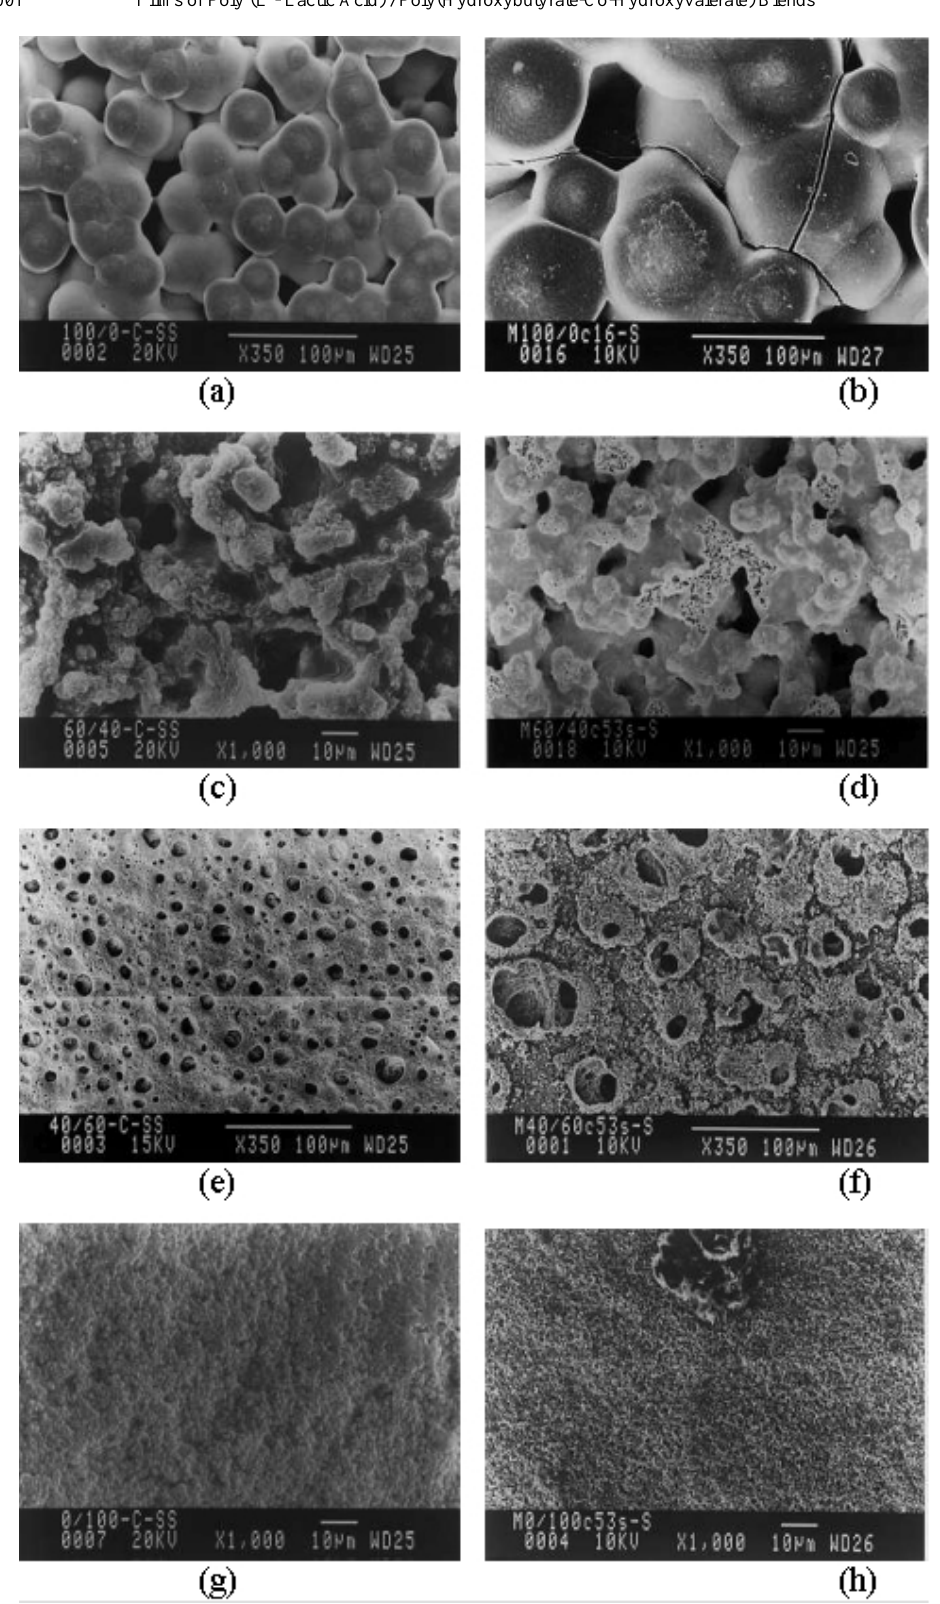
Figure 8. Electron micrographs of upper surfacesof PLLA/PHBV blends of differentcompositions and submitted to differentdegradation periods: 100/0 (a), 60/40 (c), 40/60 (e) and 0/100 (g), t = 0 weeks; 100/0 (b), t = 16 weeks; 60/40 (d), 40/60 (f) and 0/100 (h), t = 53